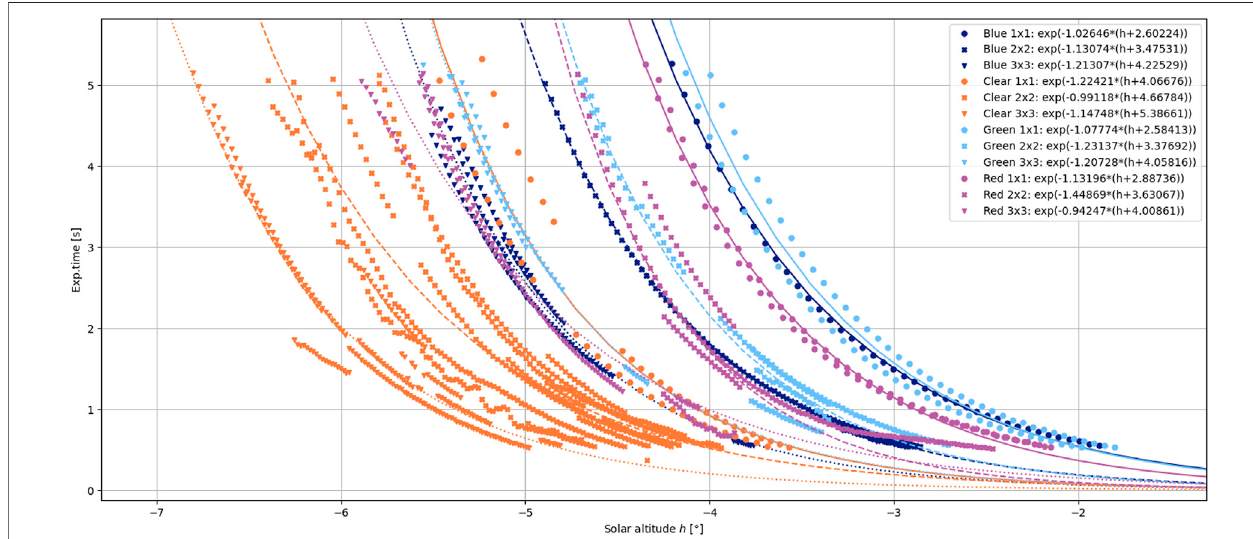
FIGURE 4 | An example for empirical models for fl at fi eld exposure times. The points are optimal exposure times for getting a mean fl ux of 30,000 counts in the imageasafunctionofsolaraltitude.Thecolorsindicatedifferent fi ltersandbinnings.A fi twithanexponentialfunctionwasperformedandthebestcoef fi cientsaregivenin the legend and plotted as